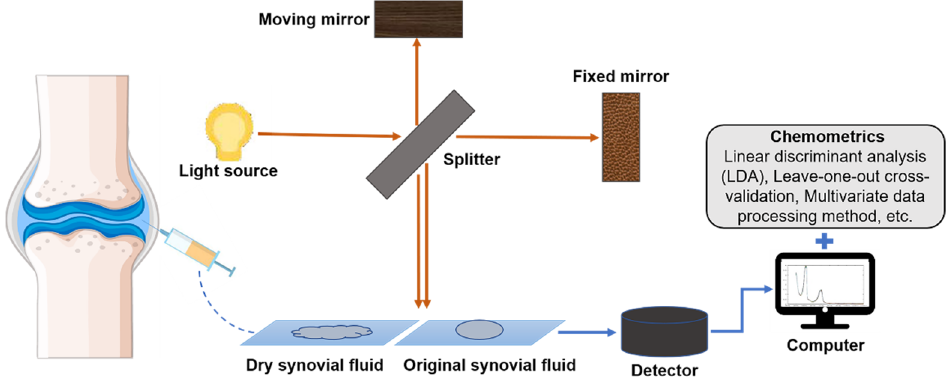
Figure 2. SF is analyzed by NIR spectroscopy. The SF extracted from the joint capsule is dried and either membrane-formed or examined directly. The light source is divided into two beams by the splitter, which are then reflected onto two mirrors—one is a fixed mirror and the other is a moving mirror. After the light is reflected, it is recombined and sent to the sample, and then the change of the light beam after the reflection and absorption of the sample is detected. Finally, the spectral data are analyzed with the help of chemometrics.